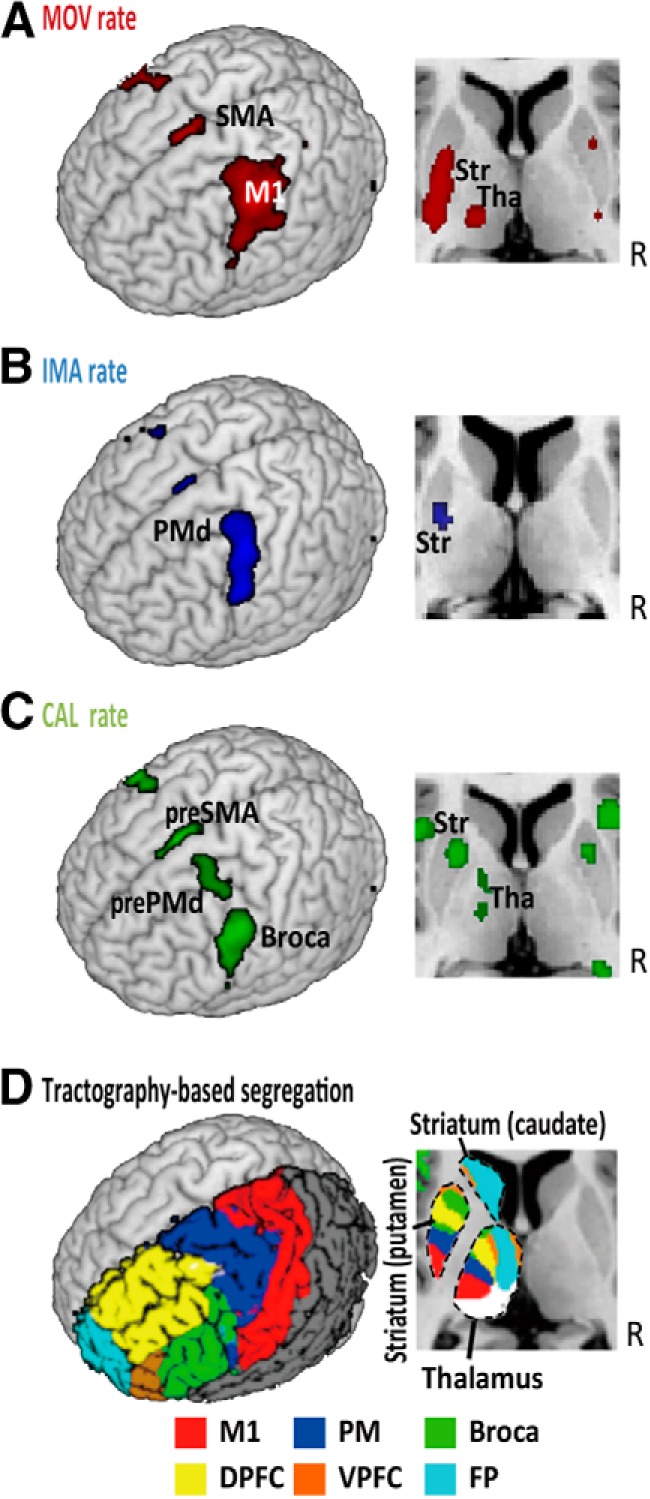
Rate-correlated activity in the BTC circuits. A, In healthy participants (n = 38), movement (MOV) rate-correlated fMRI activity was found in the primary motor cortex (M1), SMA, posterior striatum (Str), and posterior thalamus (Tha). B, Imagery (IMA) rate-correlated activity was found in the PMd, SMA, and middle Str. C, Calculation (CAL) rate-correlated activity was found in the pre-PMd, pre-SMA, IFC/Broca’s area, anterior Str, and anterior Tha. D, In an independent group of healthy participants (n = 15), probabilistic diffusion tractography identified the striatal and thalamic subdivisions connected to the M1, premotor areas (PM), IFC (Broca), ventral prefrontal cortex (VPFC), dorsal prefrontal cortex (DPFC), and fronto-polar cortex (FP).